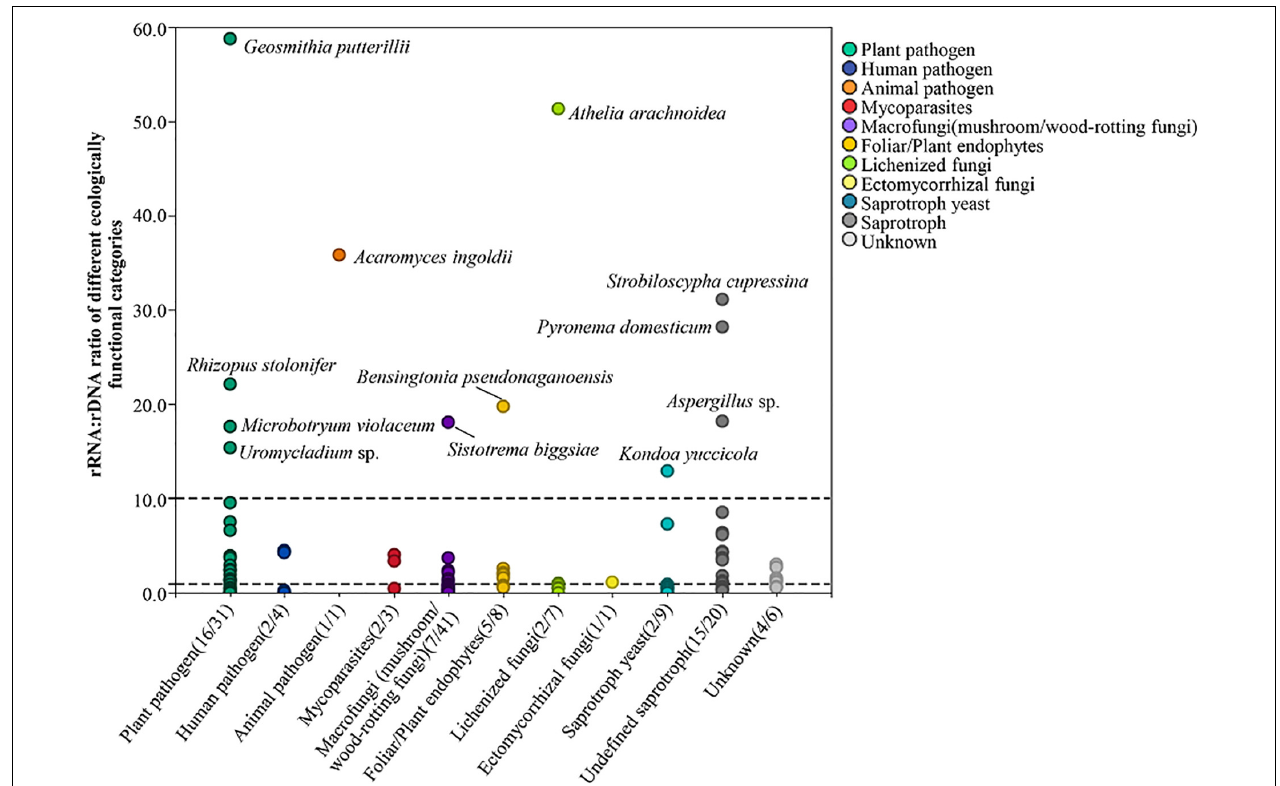
FIGURE 3 | Potential transcriptionally active fungi of different ecologically functional categories. The numbers in brackets in each category indicate the number of transcriptionally active fungal species of the group and the total number of the group, respectively.